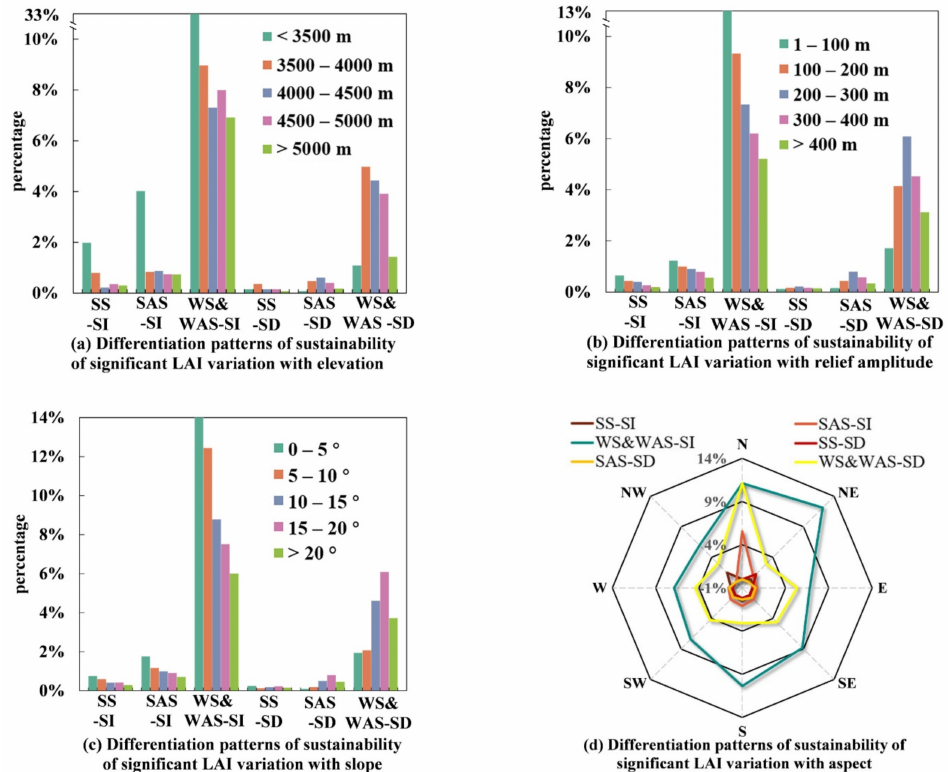
Figure 8. Differentiation patterns of sustainability of significant LAI variation with ( a ) elevation, ( b ) relief amplitude, ( c ) slope, and ( d ) aspect. Meanings of the abbreviations are shown in Figure